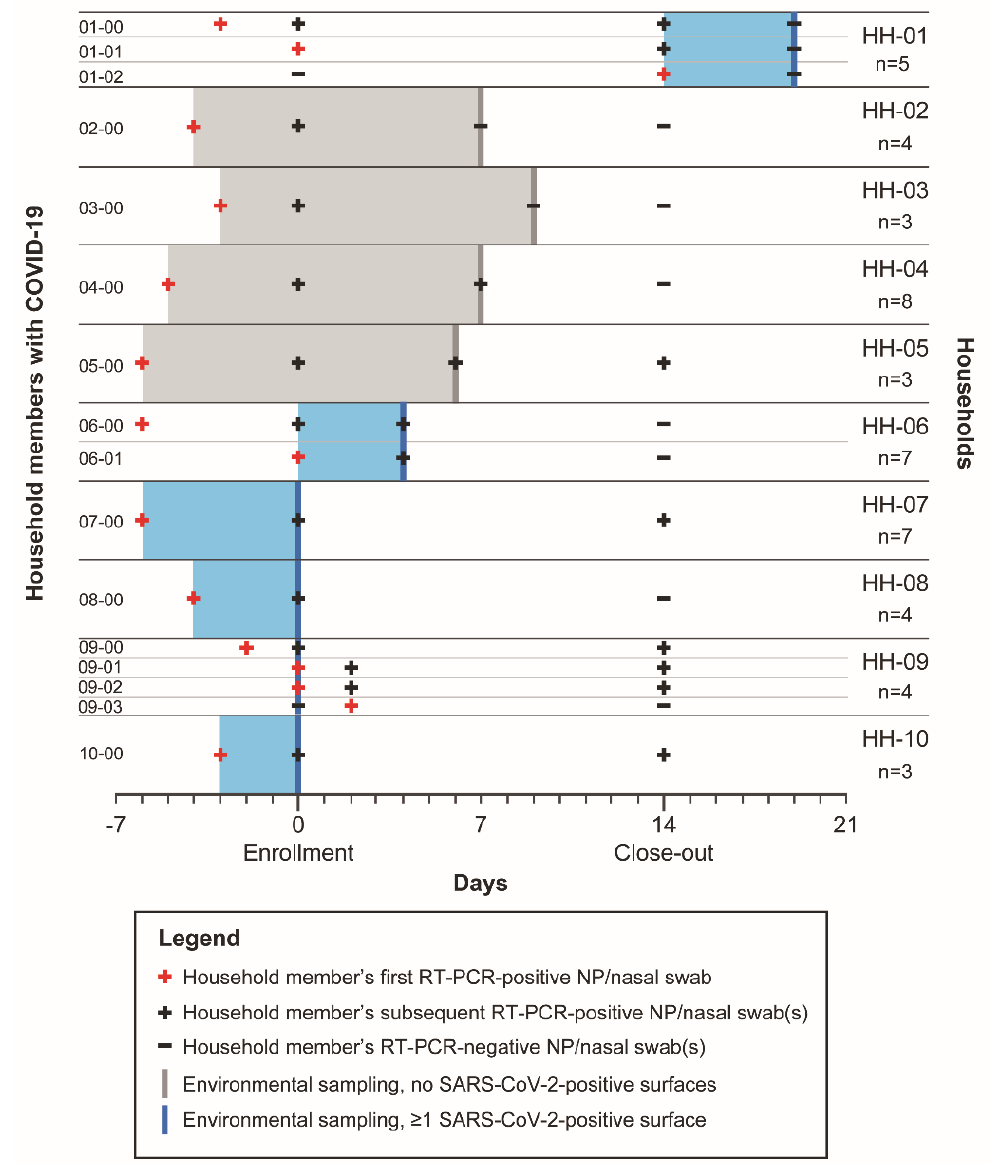
Figure 1. Timing of RT-PCR-positive SARS-CoV-2 tests among household (HH) members and environmental detection of SARS-CoV-2 in households. SARS-CoV-2 RT-PCR-positive tests from nasopharyngeal (NP) or nasal swabs for each household member with COVID-19 (left) in each household (right) are designated with “plus” symbols, with red symbols designating each person’s first SARS-CoV-2-positive test, and black “plus” symbols designating subsequent positive tests. Negative tests are designated with black “minus” symbols. Only household members who tested positive for SARS-CoV-2 over the course of the study are graphed, and “n” designates the total number of members per household inclusive of persons who never tested positive during the study. Secondary transmission is observable in households with contacts testing positive for SARS-CoV-2 by RT-PCR on their NP or nasal swabs for the duration of the study. Environmental sampling days are designated with thick vertical lines, and days elapsed between the first positive test in the most recent household member with COVID-19 and environmental sampling is designated with shaded bars. Blue indicates that SARS-CoV-2 RNA was detected in the household environment, while gray indicates that no surfaces tested positive for SARS-CoV-2 RNA. Note: Shaded bars precede enrollment (day 0) if the most recent household member with COVID-19 first tested positive prior to enroll- ment. HH-09 has a thick vertical blue line but does not have a shaded bar as the most recent house- hold members with COVID-19 (Case IDs 09-01 and 09-02) tested positive for the first time on the day of environmental sampling (day 0). No NP or nasal swab was collected from the index case in HH-09 (Case ID 09-00) on day 2.